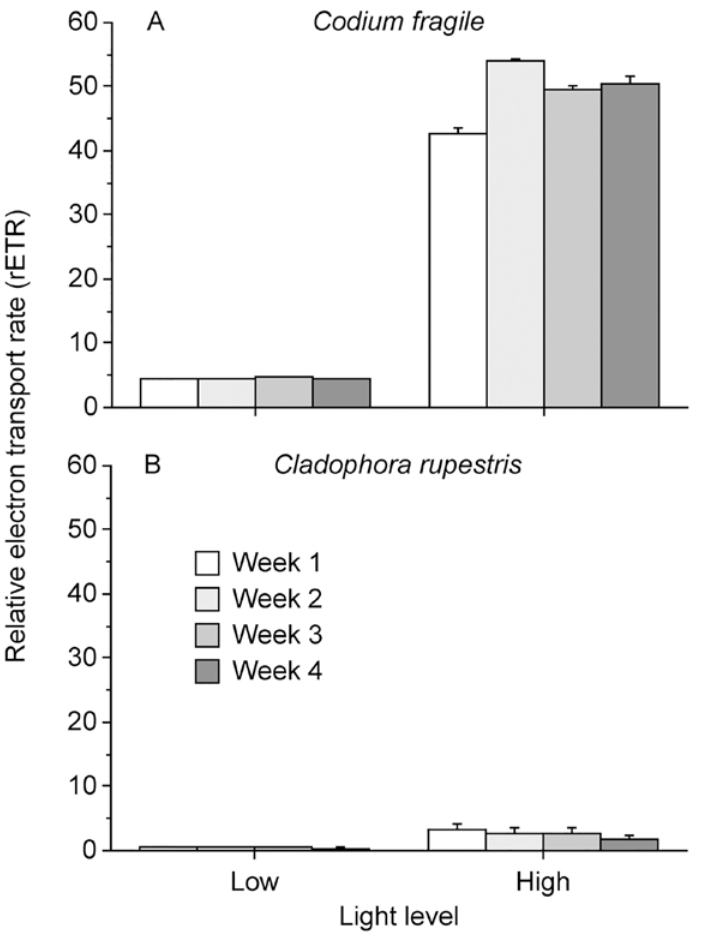
Fig 2. Relative electron transport rate of photosystem II (rETR) in Elysia viridis from A) Codium fragile and B) Cladophora rupestris fed their original algal host diets under low and high light during four- week experiments. Error bars show + SEM (n =